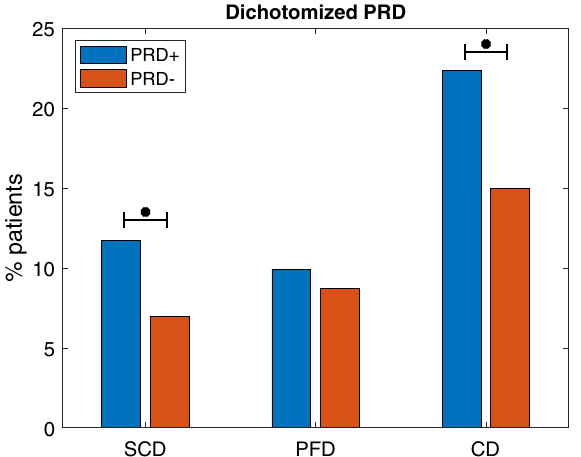
Figure 1. Percentages of SCD, PFD and CD victims in PRD + and PRD − groups. ∗ p < 0.05 .